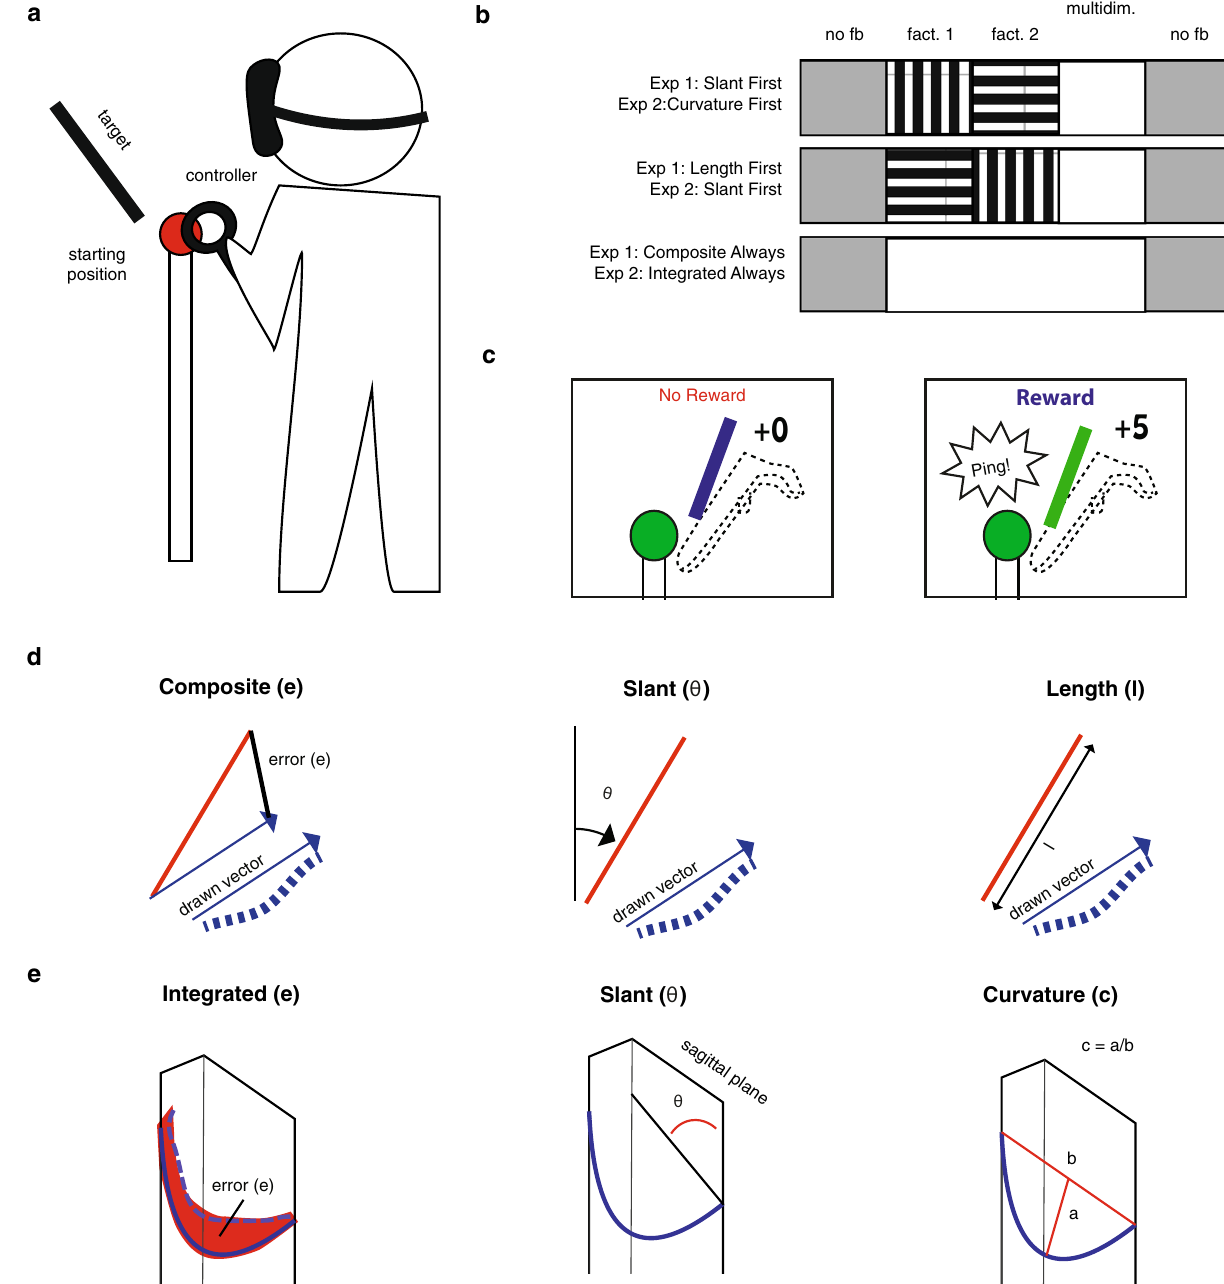
Figure 8. General methods. ( a ) Cartoon illustration of the set-up, target, starting position, and participant (not drawn to scale). ( b ) Order of feedback for the different groups in the different phases of the experiment (baseline, learn1, learn2, learn3, and retention phase). Striped blocks represent phases in which the participant received feedback on a single factor. ( c ) Binary reward feedback. ( d ) Target trajectory (red), actual trajectory (dashed blue curve), and factors used in Experiment 1. ( e ) Target trajectory (continuous curve), and factors used in Experiment